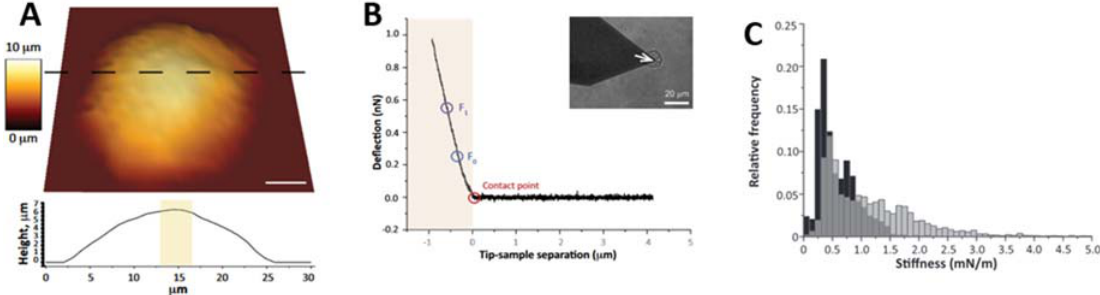
Figure 4. ( A ) A low-resolution topography of the nucleus can be obtained from F-D curve analysis. Nucleus thickness is derived from AFM topography. The 40 × 40 F-D curves (n = 1600) were acquired from a 30 μ m × 30 μ m square area. ( B ) A typical F-D curve acquired from an isolated nucleus. Nuclear stiffness was derived from all the acquired F-D curves, calculating the slope of the linear fit performed between two points at fixed forces, F 0 = 0.25 nN and F 1 = 0.55 nN. Inset: AFM probe positioned above an isolated nucleus. A spherical indenter was positioned at the cantilever free end (white arrowhead). ( C ) Nuclear stiffness increased in ADLD human skin fibroblasts as can be seen in the representative stiffness distributions accumulated from CTR (black) and ADLD (gray) cells. Reprinted with permission from Ref. [90]. 2014, The FASEB Journal.